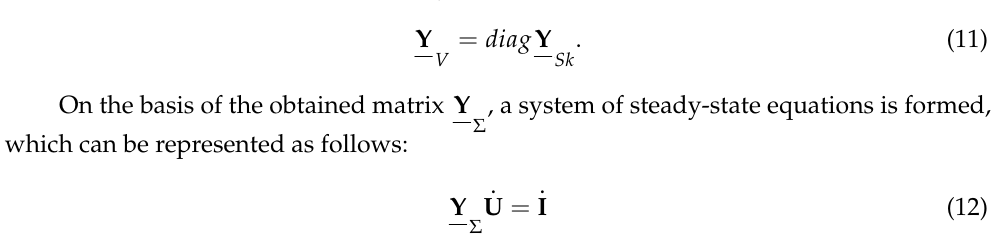
means that the direction of the connection is “from the hub”, and the minus sign means “to the hub”. The block diagonal matrix Y